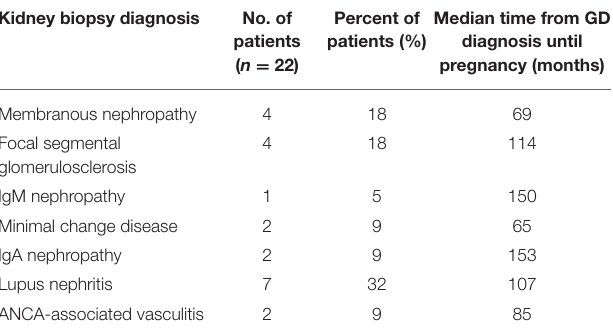
TABLE 2 | Diagnosis of glomerular disease ( n =